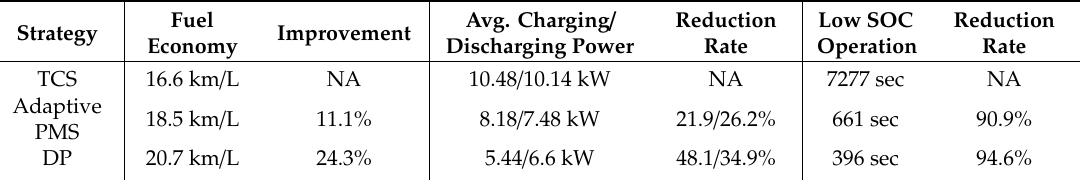
Table 4. Comparison of TCS, adaptive PMS and DP for 10 NEDC.